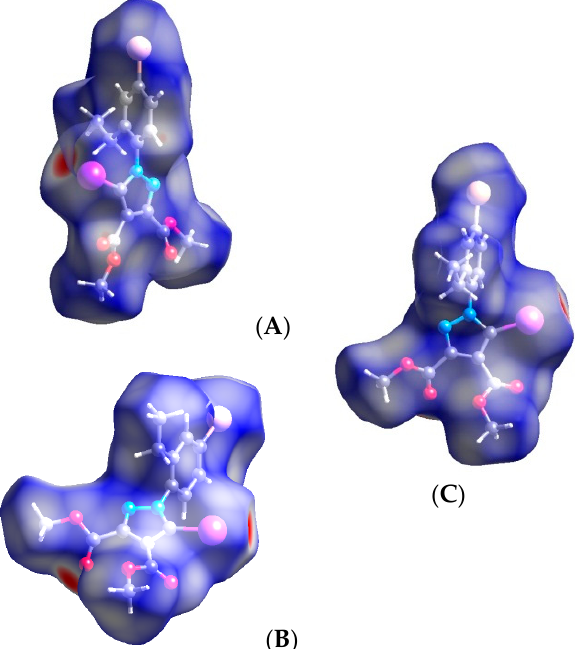
Figure 15. Hirshfeld surface of compound 4 showing the C-I ⋯ O contact red spots ( A – C ). Halogen bond parameters: C-I bond length: 2.056 Å; I ⋯ O distance: 2.951 Å; sum of the vdW radii: 3.5 Å [58]; ∠ C-I ⋯ O: 175.9°.